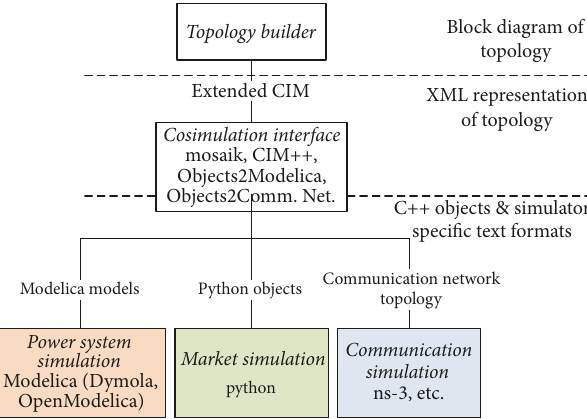
Figure 4: Overall architecture for simulation